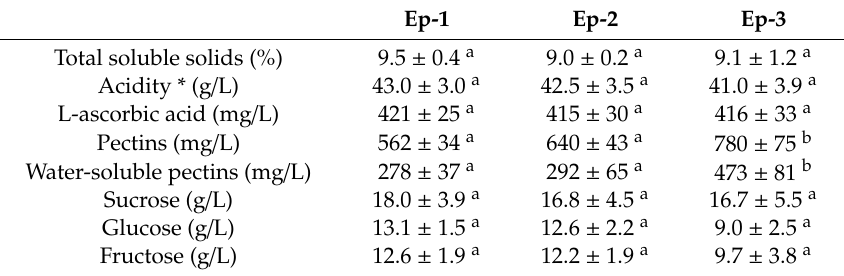
Table 1. Proximate constituents (mean ± standard deviation, n = 3) of bergamot juice obtained using 3 di ff erent extraction methods: hand squeezing (Ep-1); FMC (Ep-2); screw press of peeled fruits